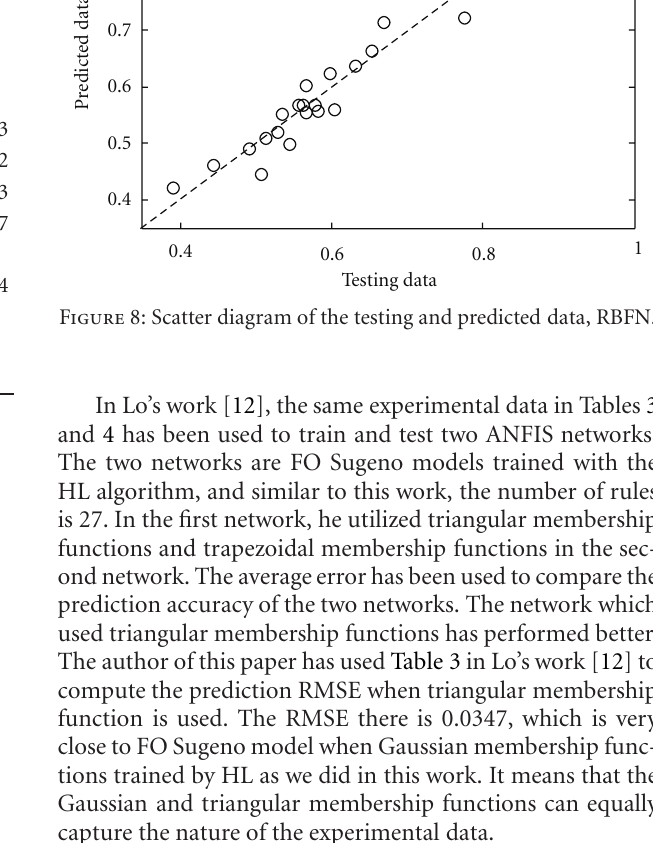
Figure 7: The prediction error of the testing data, RBFN.